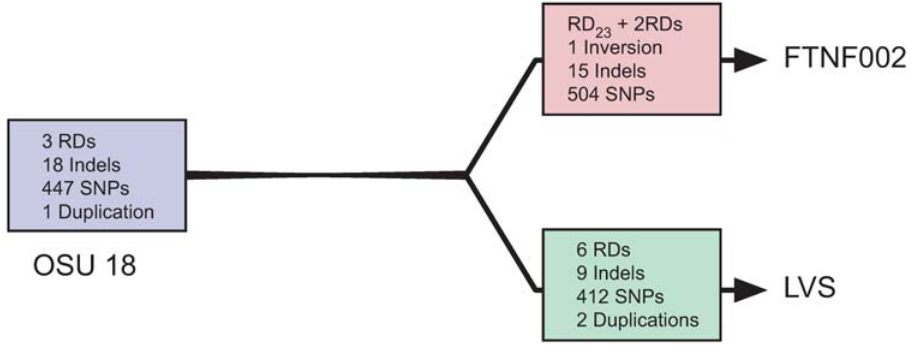
Figure 3. A genome-based model depicting the divergence of the FTNF002 and LVS from the more ancestral OSU18.